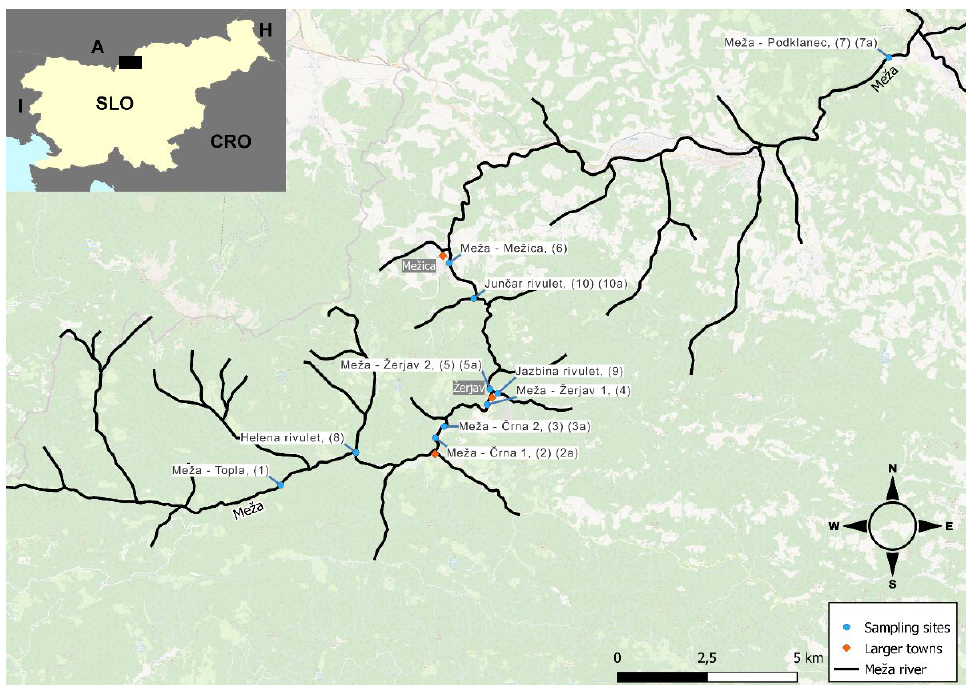
Figure 1. Sampling area with sampling